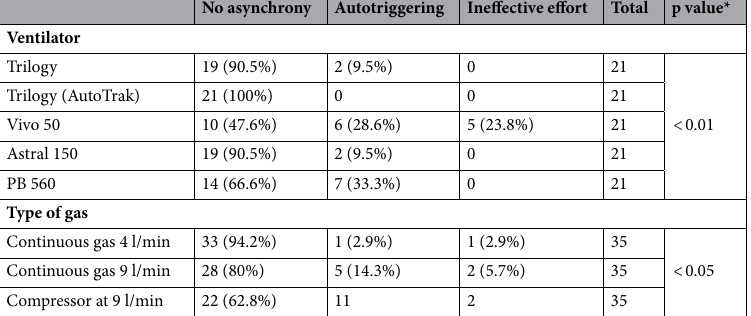
Table 5. Percentages and types of asynchronies induced by the introduction of external gas as a function of the variables controlled in the clinical model. *Chi-square